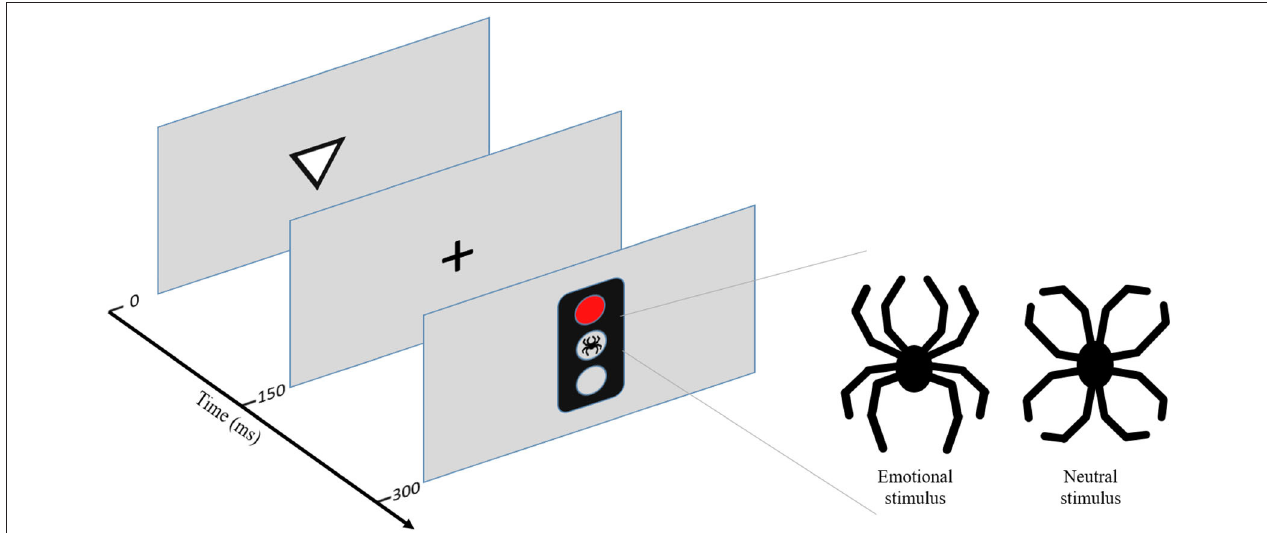
FIGURE 1 | Executive Reaction Time (RT) Test. Executive RT Test is a computer-based experimental Go/NoGo test with threat-related distractors (48). Executive RT Test has been designed to engage multiple executive functions (working memory, inhibition, attention, and shifting) simultaneously to mimic real life requirements for executive functions. Additionally, Executive RT Test has an emotional component in the form of a threat-related distractor to simulate real life situations where executive functions are needed in emotionally charged situations. The task of the subject is to indicate the orientation of the triangle by pressing one of the two response buttons as fast as possible when a Go signal is presented and withhold from responding when a NoGo signal is presented. The color of the traffic light indicates a Go- or a NoGo trial, with green light indicating a Go trial and red light indicating a NoGo trial in half of the blocks and the other way round in the other half of the blocks. The rule for responding changes every two blocks. There are 64 trials in 8 blocks. The outcomes of the test are RTs and error rates. Different error modalities are assumed to reflect different aspects of executive functions; incorrect responses reflect lapses in working memory, missed responses lapses in attention, and commission errors failures in response inhibition. Individual error types can be summed up to reflect overall performance. RTs reflect overall executive functions and have been shown to correlate with subjective evaluations of executive functions in daily life in healthy subjects ( 49). The test has been previously used to detect subtle changes in executive functions, both impairments and improvements, due to neuromodulation ( 46, 50, 51), mild traumatic brain injury (MTBI) (48), and major cardiac operations (52). In addition, the test is sensitive in depicting alterations in emotion–attention interaction due to MTBI (53), focal brain injury (54),